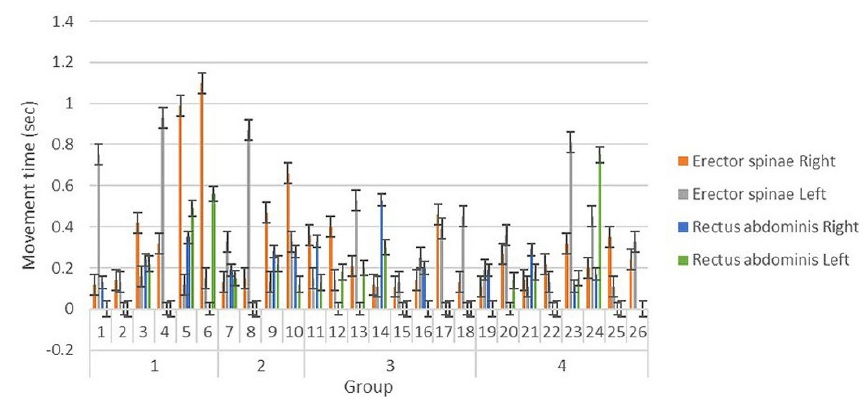
Figure 1. Signal of movement time.